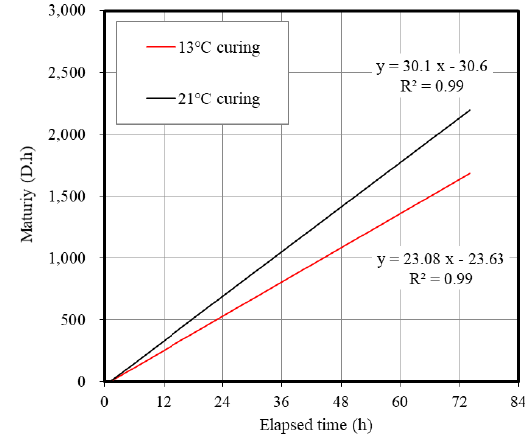
Figure 3. Maturity of concrete according to the elapsed time.